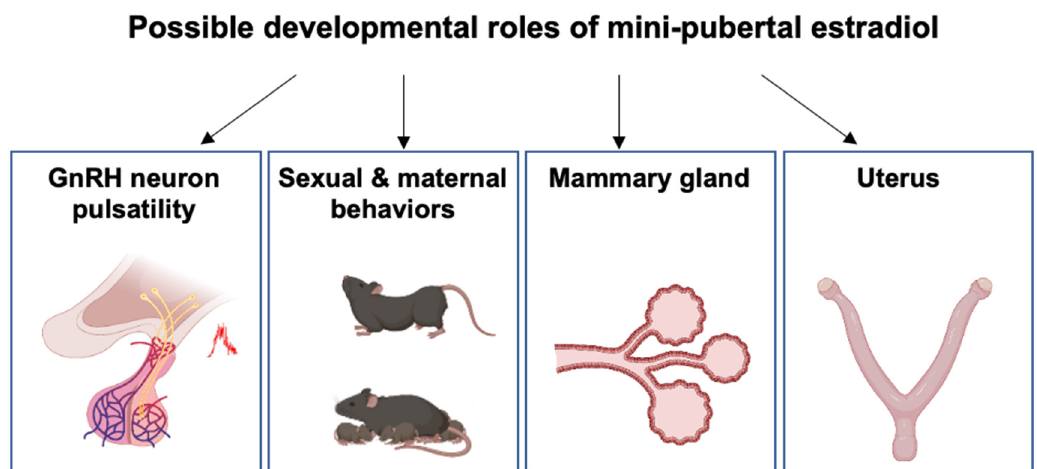
Figure 6. Possible roles of mini-pubertal estradiol on different organs related to reproduction. This hormone could play a pleiotropic role in the body by regulating the development and differentiation of several target tissues, including the hypothalamic system driving GnRH pulsatility, several brain areas contributing to sexual and maternal behaviors (amygdala, olfactory system, hypothalamus), the mammary gland and the uterus. See references in the